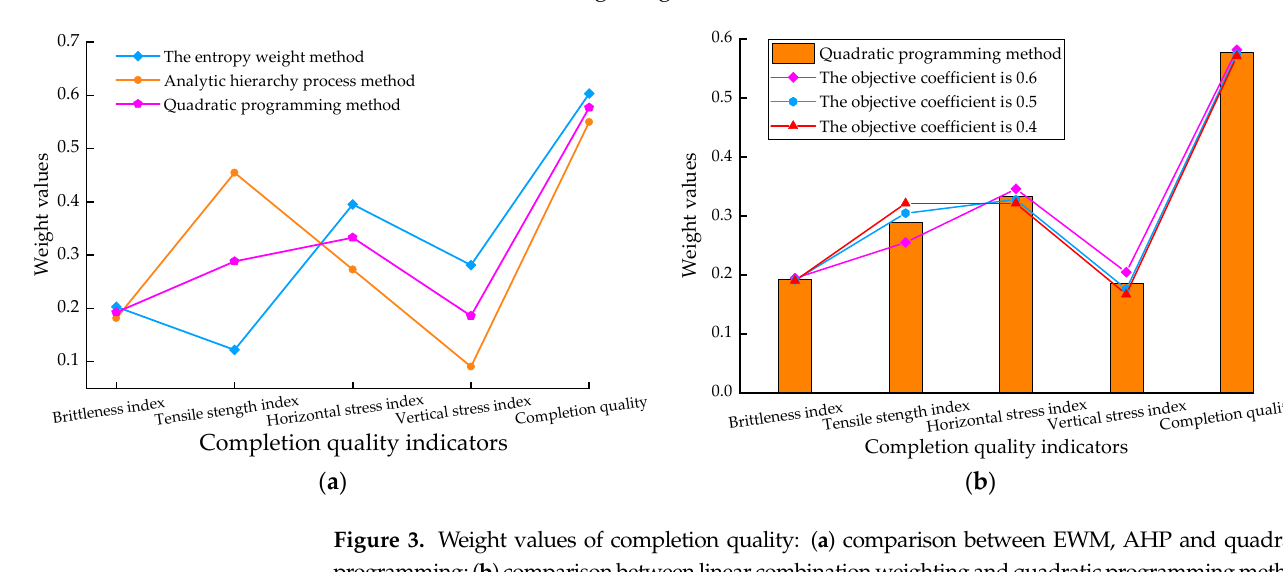
Figure 2. Weight values of reservoir quality: ( a ) comparison between EWM, AHP, and quadratic programming; ( b ) comparison between linear combination weighting and quadratic programming method.